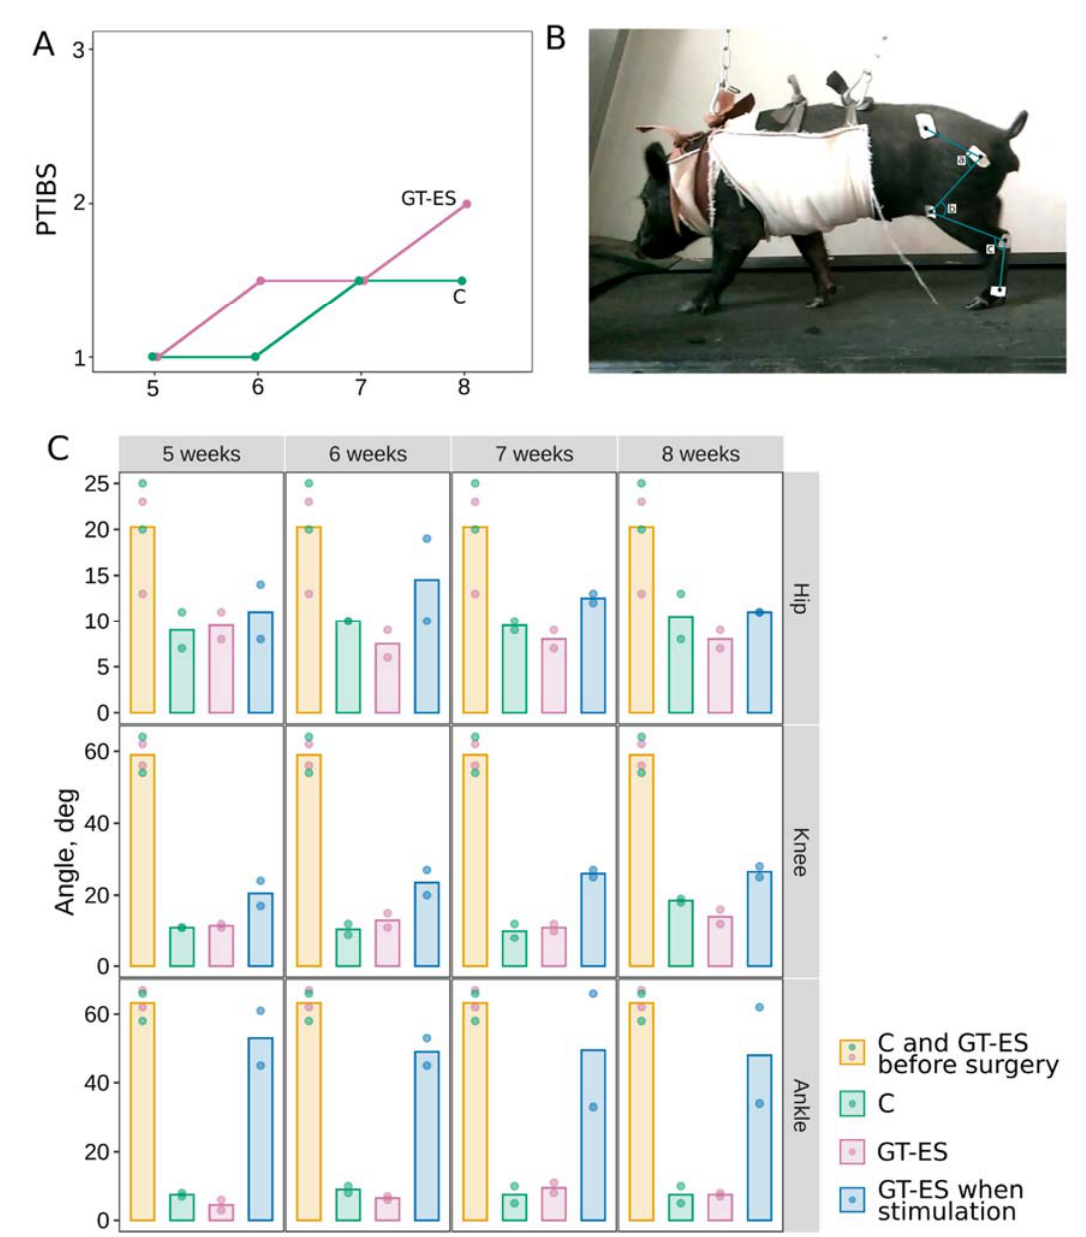
Figure 2. Evaluation of the motor recovery. ( A ) Porcine thoracic injury behavioral scale (PTIBS) scores in control (green) and treated (pink) groups. ( B ) Video recording of the hip ( A ), knee ( B ), and ankle ( C ) joint kinematics during stepping on a treadmill was performed in intact healthy pigs 1 week before surgery and at di ff erent time points after spinal cord contusion injury. ( C ) The angle (degree) of movements measured in the hip, knee, and ankle joints in experimental pigs before surgery (I, yellow bar) and week 5, 6, 7, and 8 after spinal cord injury (SCI) in control (C, green bar) and treated (GT-ES, pink bar) groups during training on the treadmill. The blue bar (GT-ES when stimulation) represents data of animals from the GT-ES group during training on the treadmill enabled with epidural stimulation at the L2 segment. Average angles of five sequential step cycles for each animal are presented as color points; bars correspond to group-wise average values. The colors of points in I (yellow bars) correspond to the colors of C and GT-ES bars.